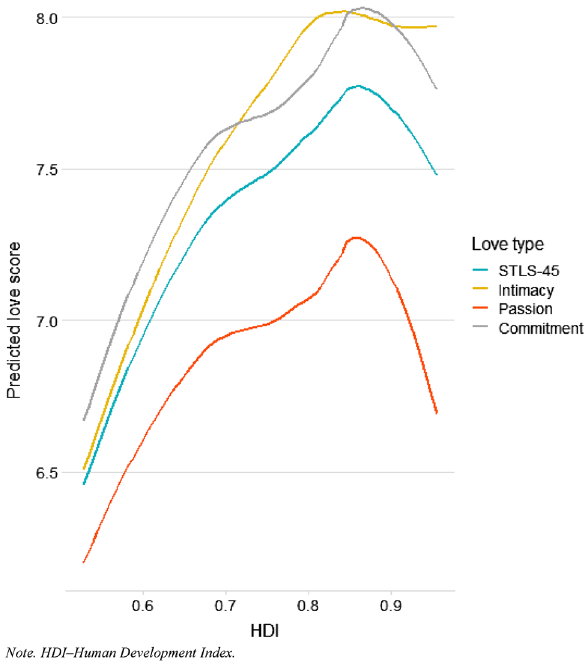
Figure 2. A graphical representation of the non-linear relationship between predicted love scores and Human Development Index (controlling for country’s collectivism, average annual temperature, and participants’ sex and relationship